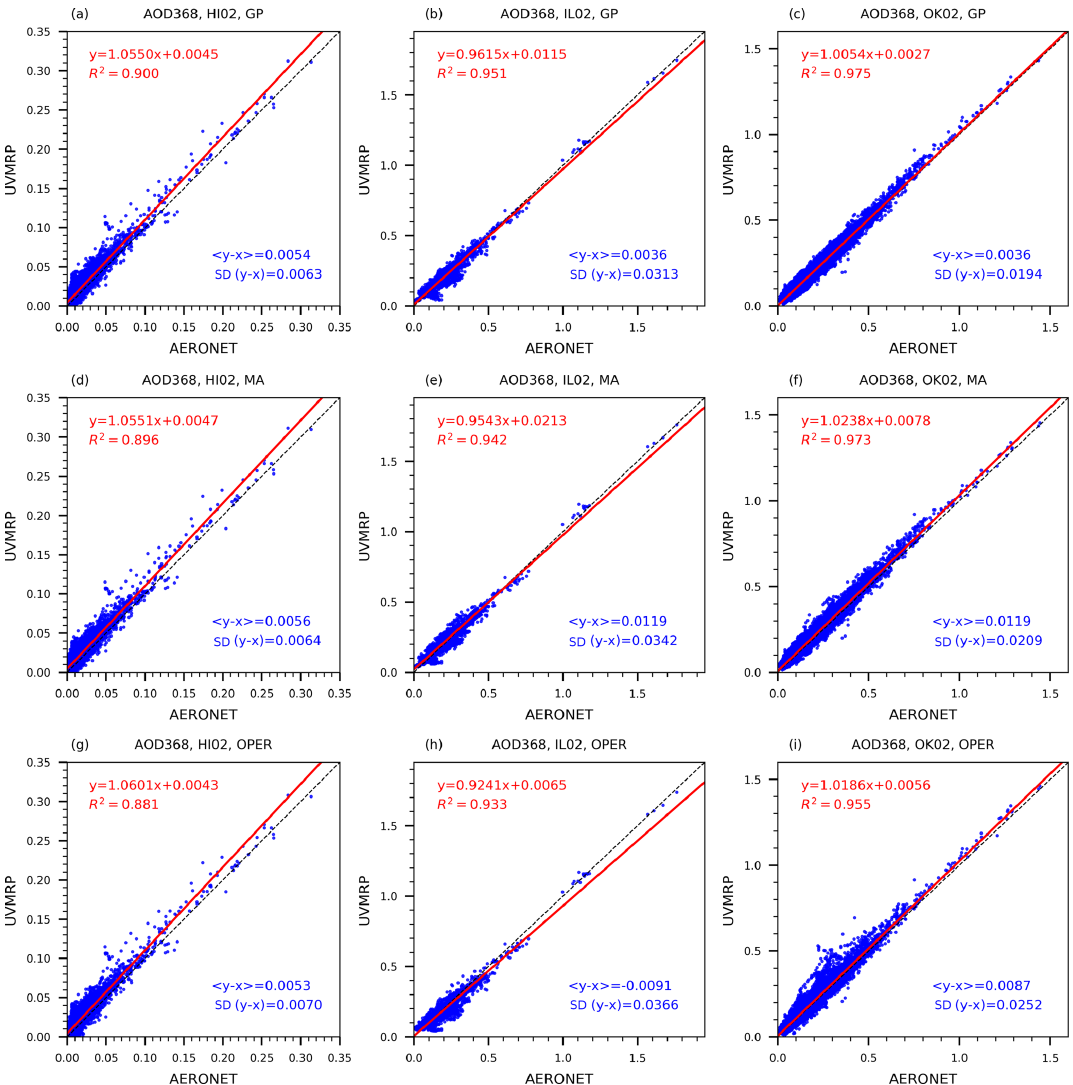
Figure 4. The 368nm AOD scatter plots between UVMRP ( y axis) and AERONET ( x axis). The UVMRP 368nm AODs are calculated from UV-MFRSR direct normal voltages using calibration factors estimated by the three methods (i.e., from top to bottom: GP, MA, OPER) at the three sites (i.e., from left to right: HI02, IL02, OK02). Panels (a) , (b) , and (c) display the scatter plots for the GP method at HI02, IL02, and Ok02, respectively. Similarly, panels (c) , (c) , and (f) are for the MA method and panels (g) , (h) , and (i) are for the OPER method. The AERONET 368nm AODs are derived from collocated (i.e., Mauna_Loa, BONDVILLE, Cart_Site) AERONET AODs on the 340 and 380nm channels. The linear regression line (solid, red) and the 1-by-1 line (dashed, black) are also plotted. “ <y − x > ” means the average difference between AERONET and UVMRP AOD at the 368nm channel. “SD( y − x )” means the standard deviation of their